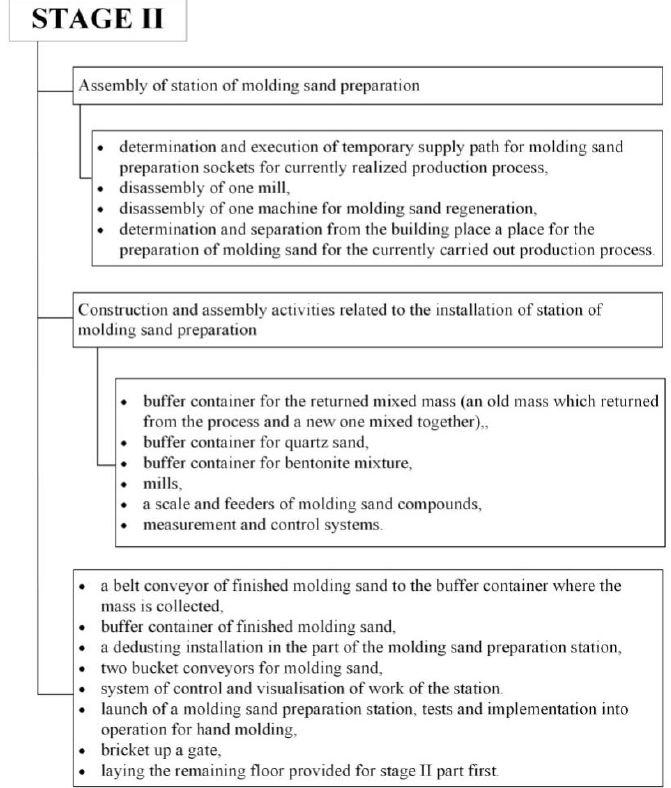
Figure 8. The second stage of modernization of the casting process.